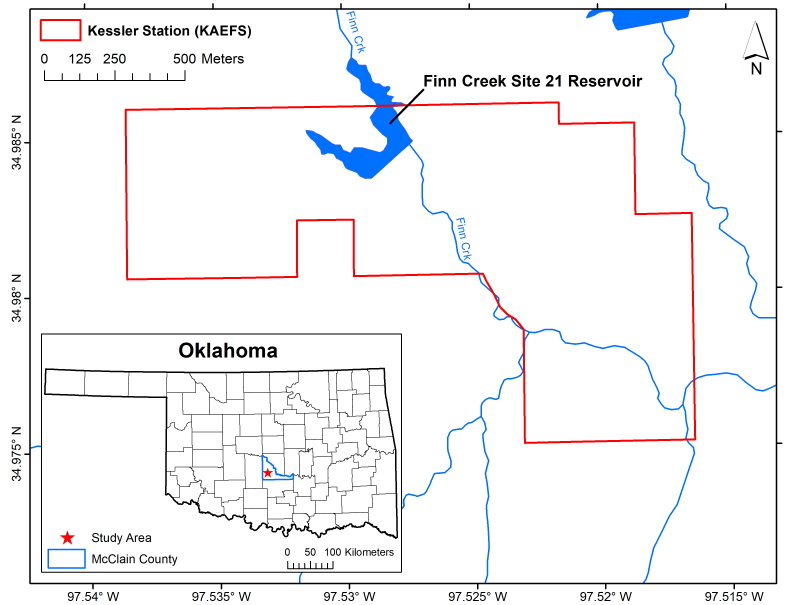
Figure 1. The location of the Finn Creek Site 21 Reservoir within KAEFS boundaries in McCain County, Central Oklahoma,